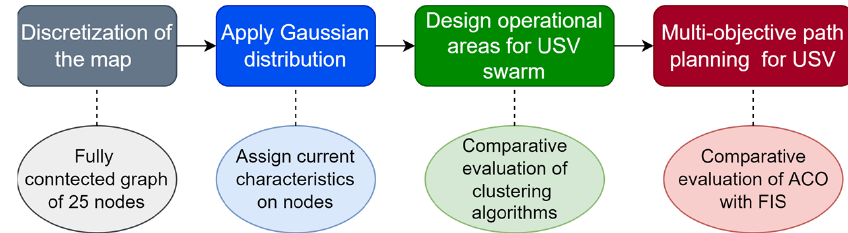
Figure 4. Evaluation steps of this study.